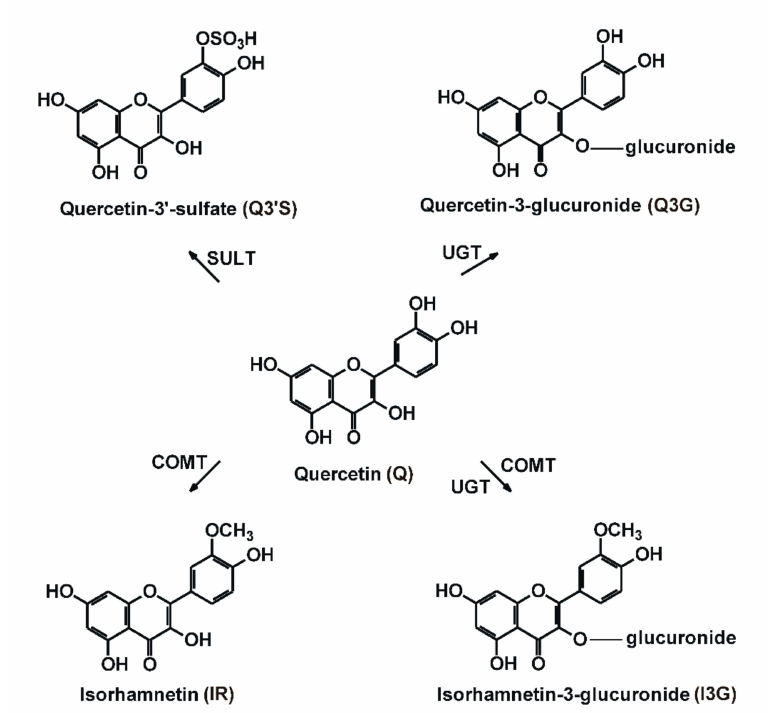
Figure 1. Chemical structures of quercetin (Q), quercetin-3 (cid:48) -sulfate (Q3 (cid:48) S), quercetin-3-glucuronide (Q3G), isorhamnetin (IR), and isorhamnetin-3-glucuronide (I3G). (COMT, catechol- O -methyltransferase; SULT, sulfotransferase; UGT, uridine 5 (cid:48)